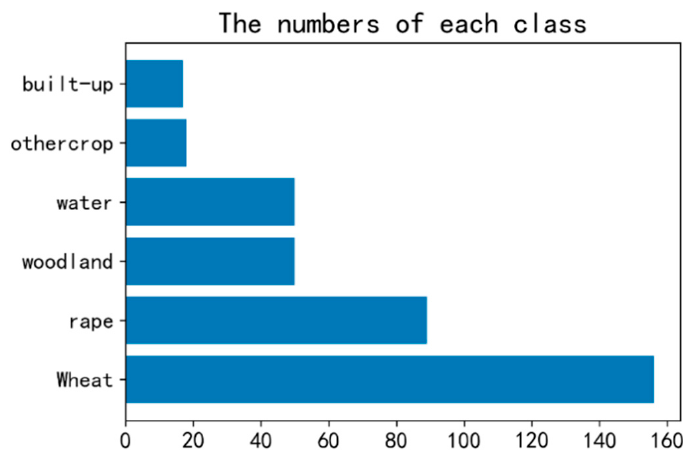
Figure 9. The numbers of sample points of each class.